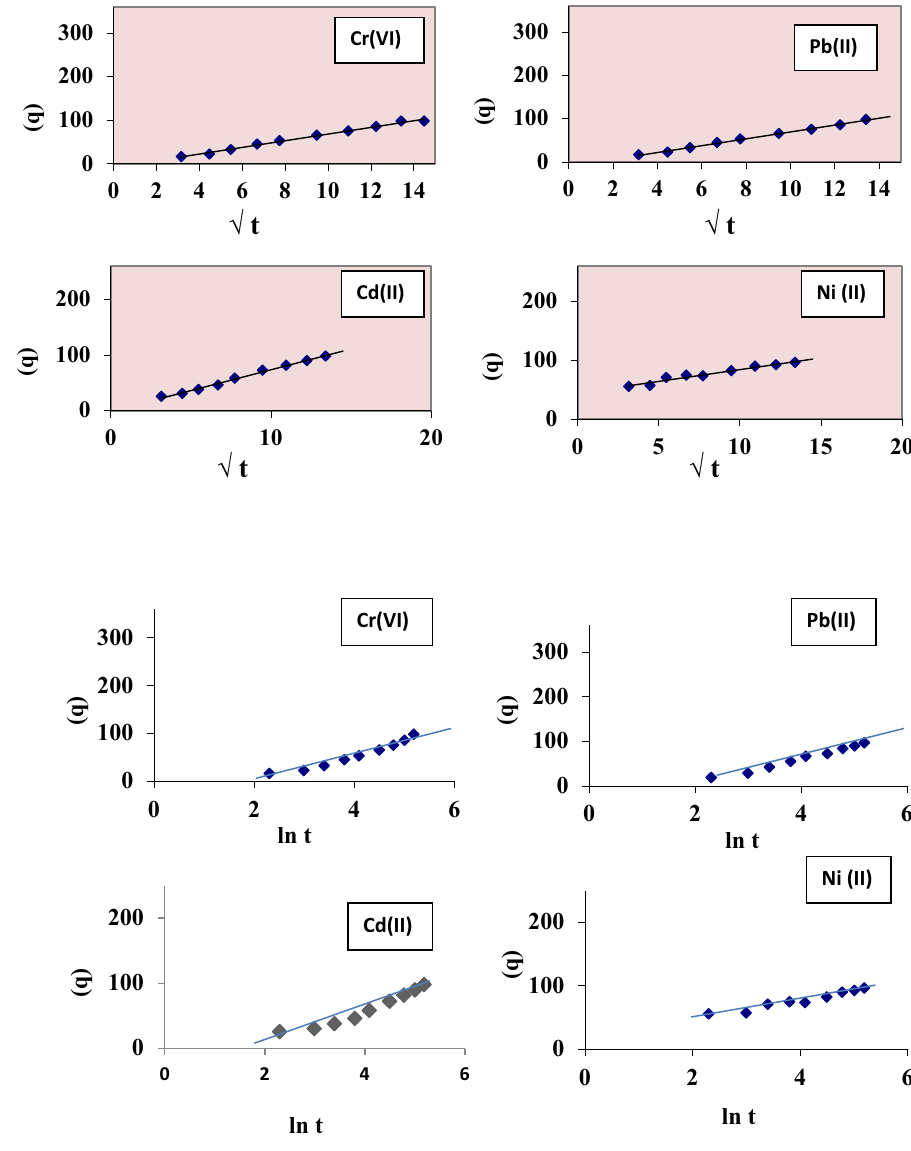
Fig. 4 Elovich’s rate equation plots for CMAC on heavy met- als adsorption